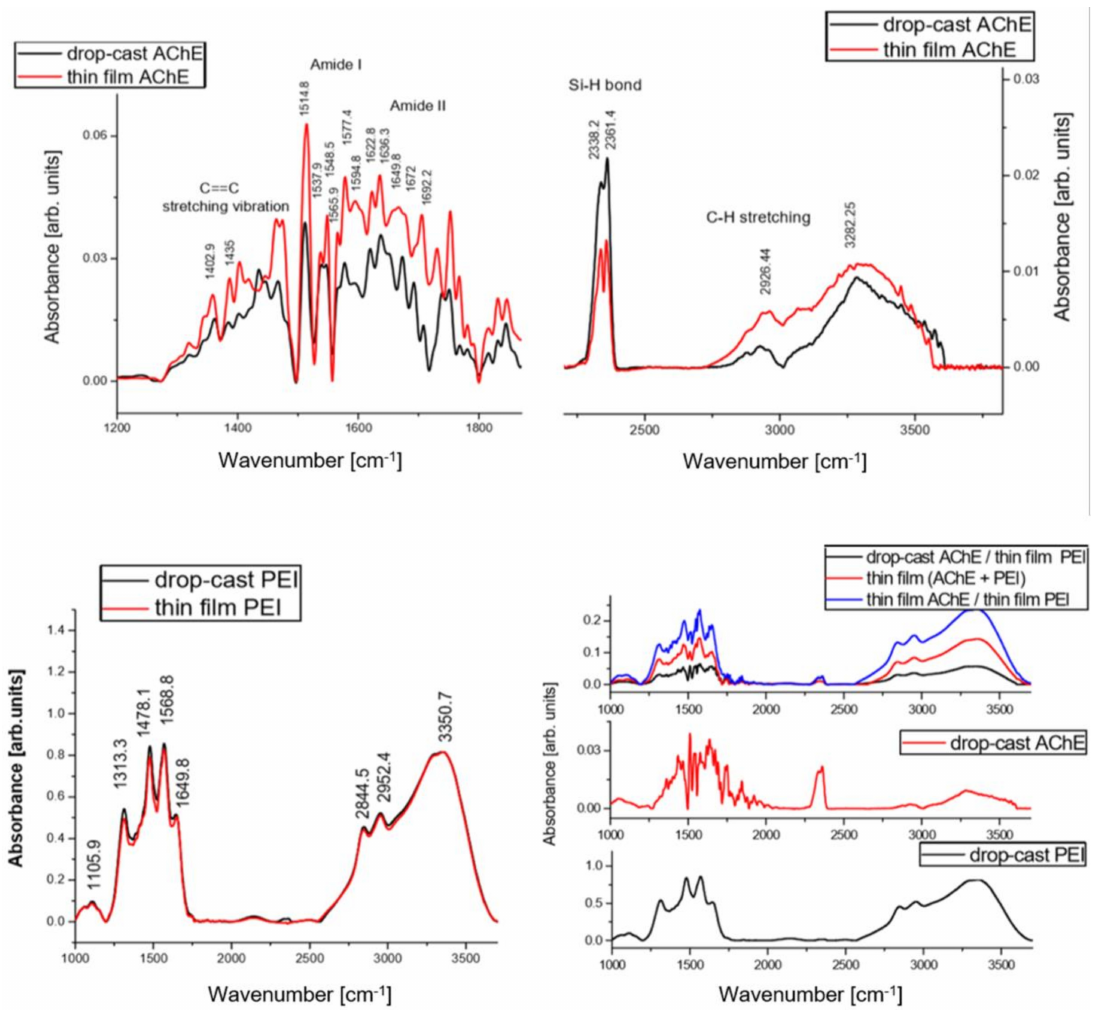
Figure 6. FTIR spectra of PEI polymer films, AchE enzyme, and PEI-AchE hybrid coatings, deposited by MAPLE and the drop-casted solution as a reference of the peaks positions and